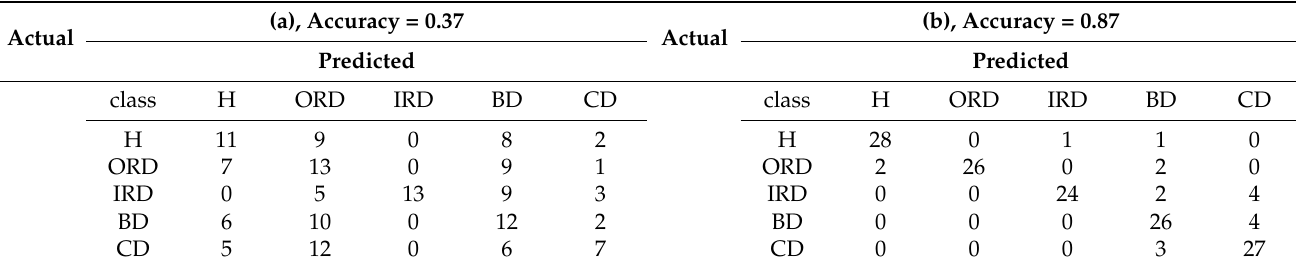
Table 3. Confusion matrices for the case of pre-processed data: (a) using conventional features; (b) using updated features. Actual